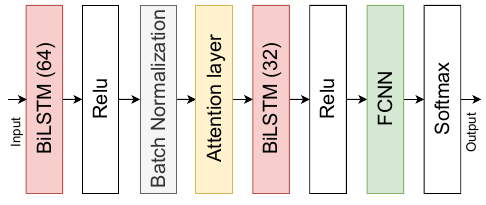
Figure 8. Hand gesture recognition